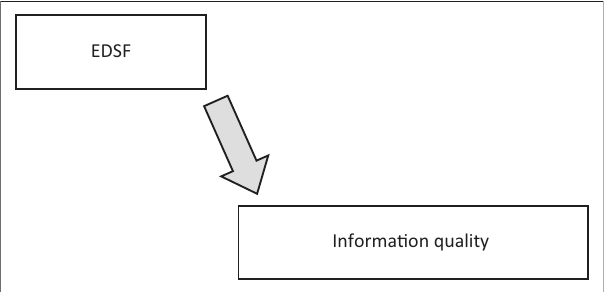
FIGURE 1: Proposed linkage between the two constructs: Information quality and executive decision support